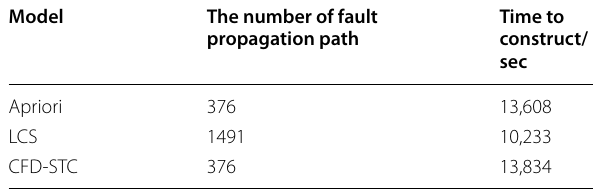
Table 4 Model performance comparison